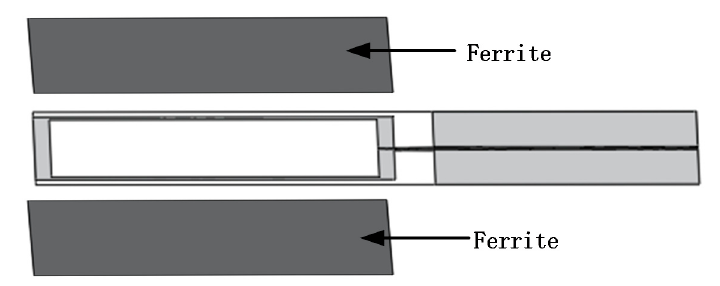
Figure 10. Probe structure with Ni-Zn ferrite sheets.